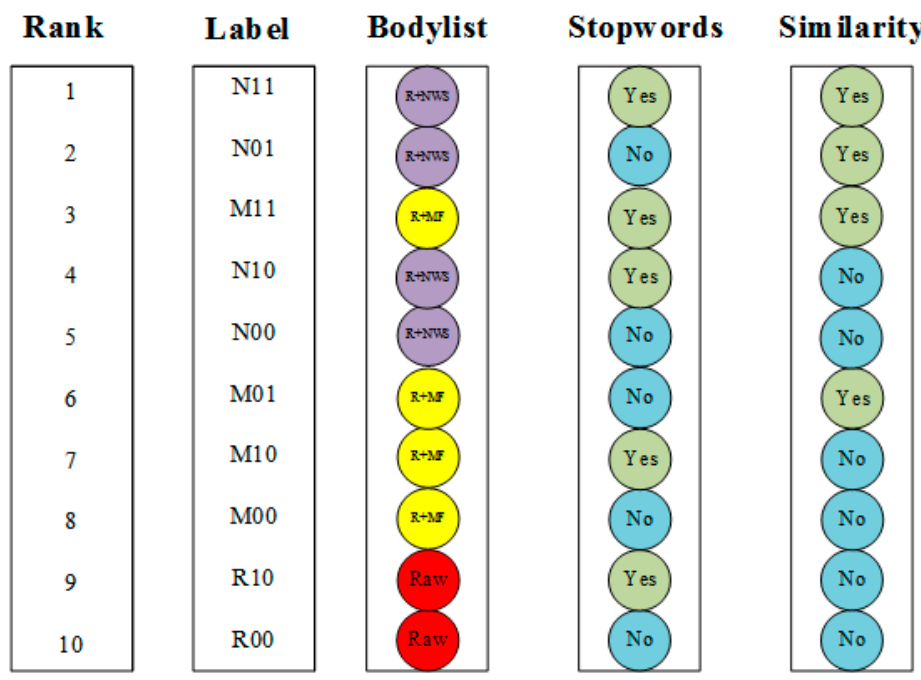
Figure 5. The di ff erence between each experiment. MF = most frequent; M = MF method; R = raw Figure 5. The difference between each experiment. MF = most frequent; M = MF method; R = raw N = N = NWS method. NWS method.